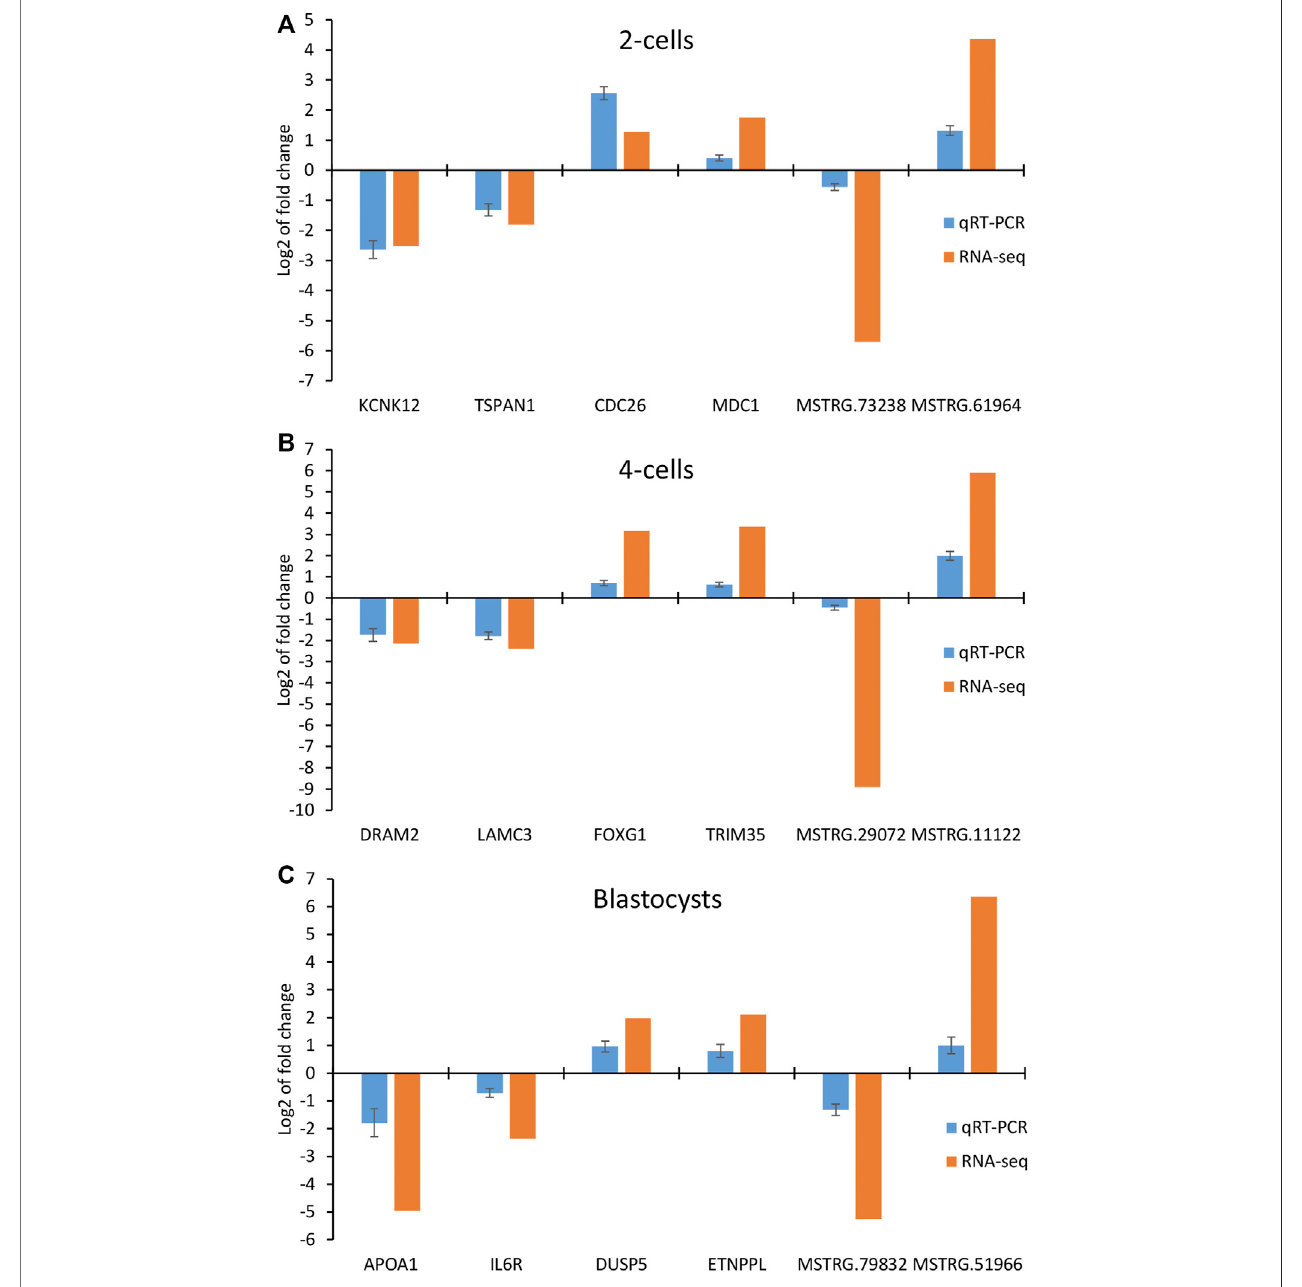
FIGURE 8 | Validation of differentially expressed mRNAs and lncRNAs in (A) 2-cells, (B) 4-cells and (C) blastocysts derived from vitri fi ed porcine cloned zygotes using qRT-PCR.